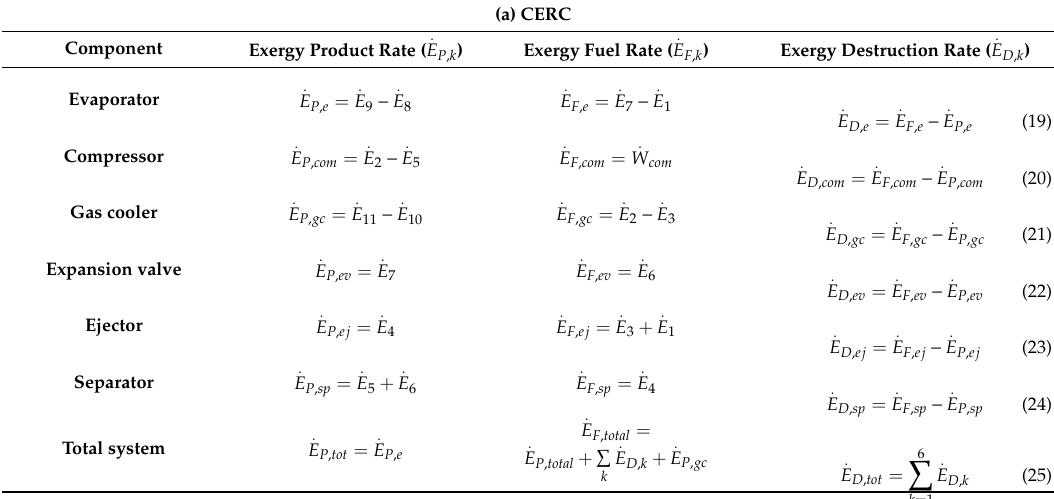
Table 3. Balance equations of the exergy rate of CERC and